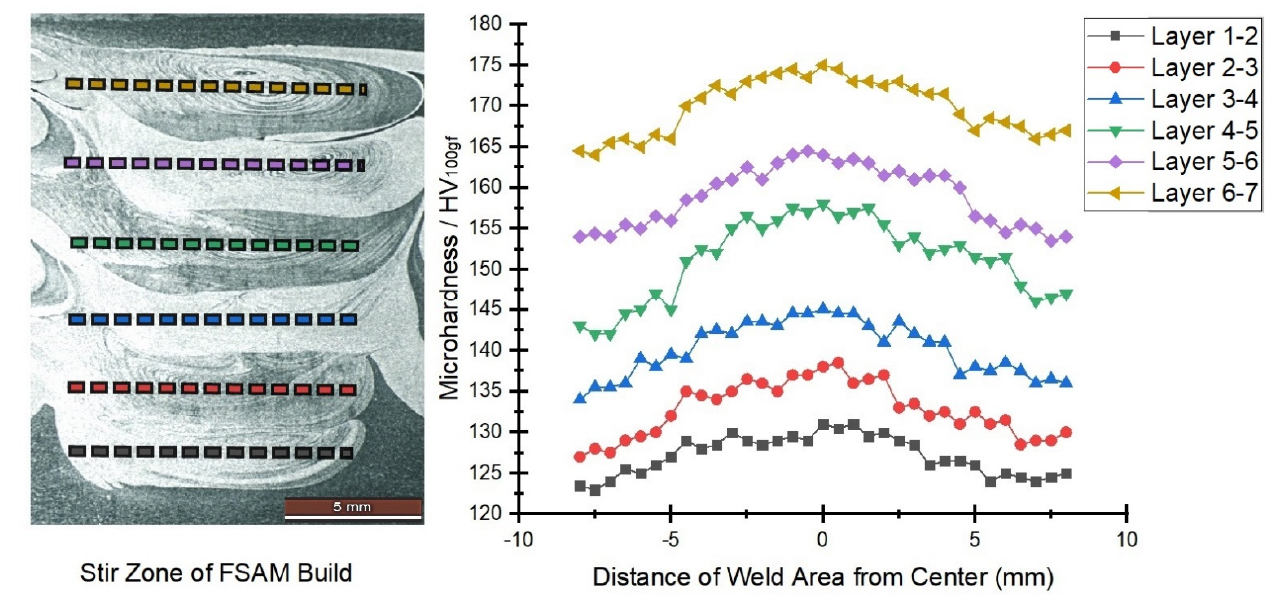
Figure 13. Microhardness analysis along horizontal direction.